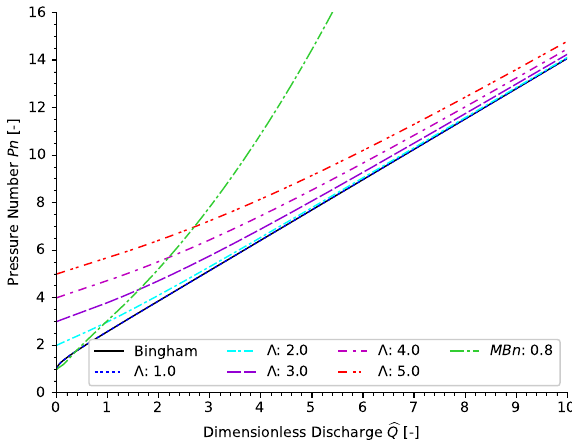
Figure 7: The discharge diagram is a powerful tool to distinguish thixotropy in the pumping behaviour. Every combination of the Bingham model is represented by a single profile. The higher the thixotropy factor Λ , the higher the influence of thixotropy on the flow regime. The thixotropy effect asymptotically wears down to the Bingham profile for larger flow rates ̂︀ Q .